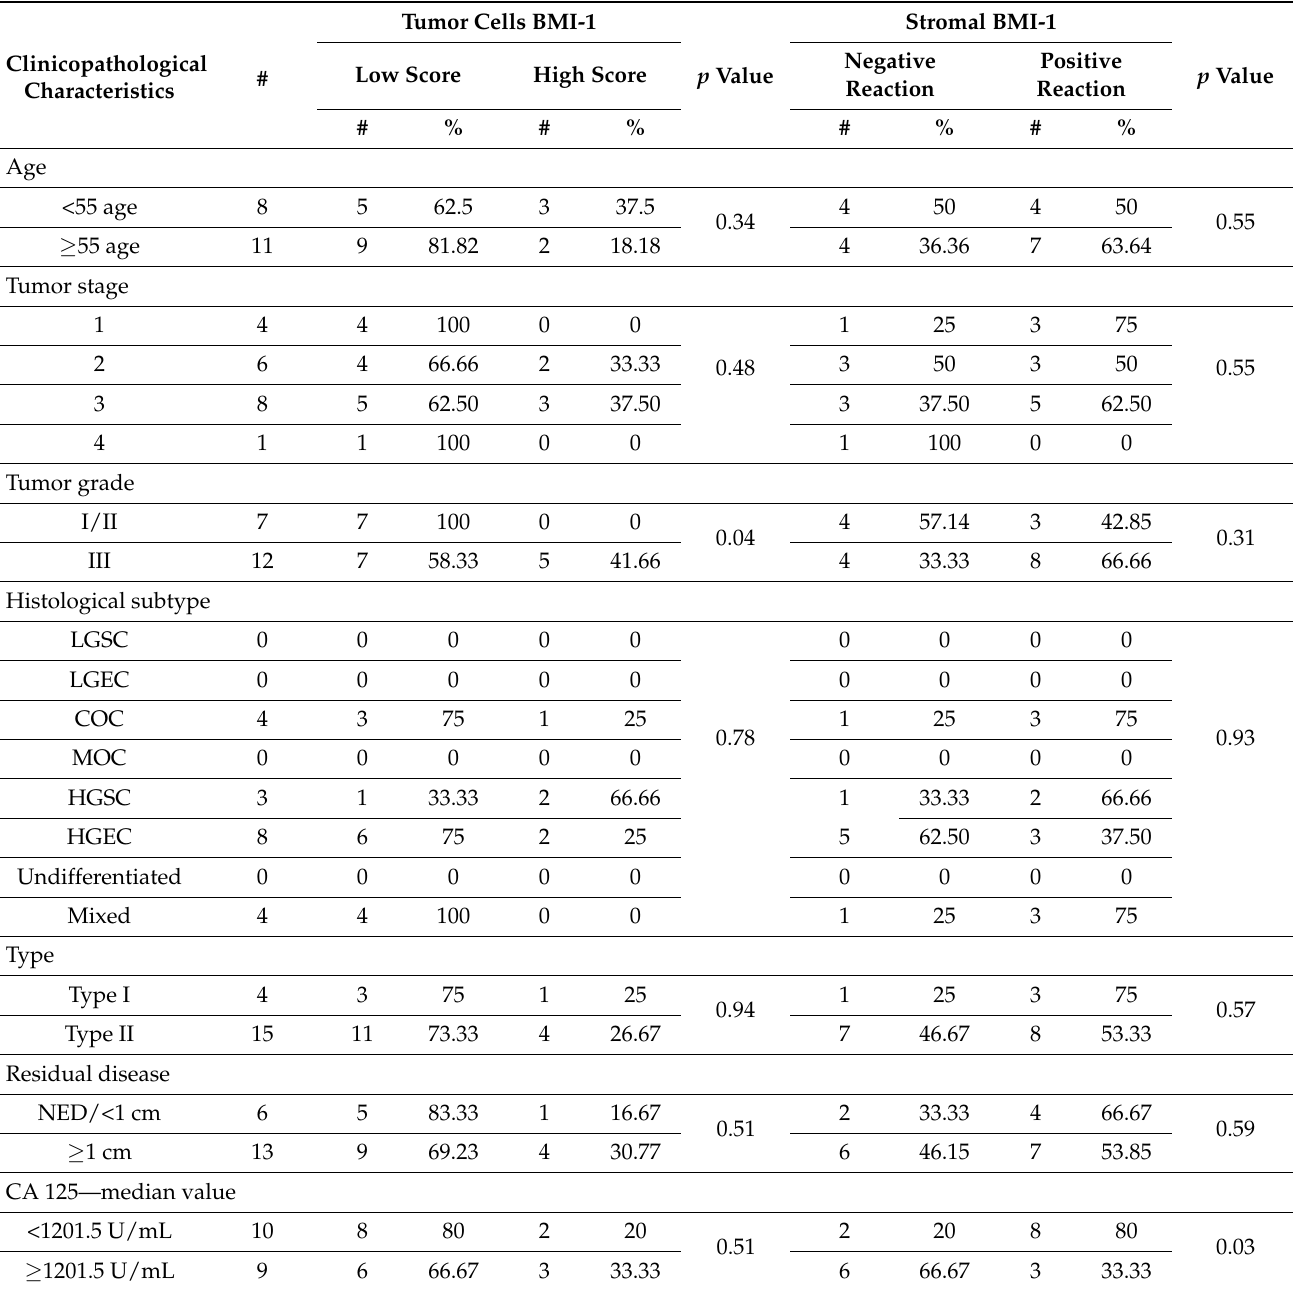
Table 2. Correlations between BMI-1 expression in tumoral cells and clinicopathological parameters—EOC group.